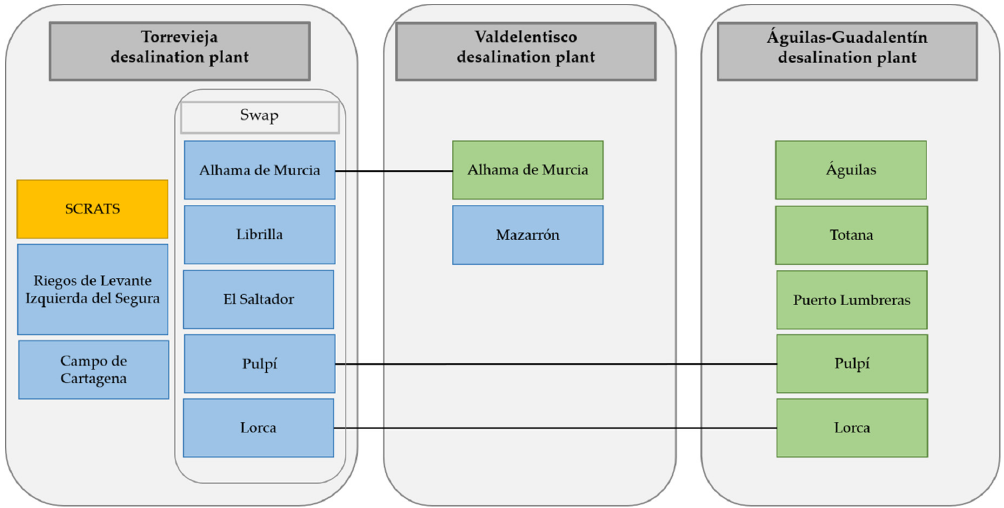
Figure 4. Irrigation communities’ connections to each desalination plant. Source: own elaboration from the questionnaires. Legend: In green, the distribution network connection to desalination plant recognized by both irrigation communities and ACUAMED; in blue, the connection only recognized by the irrigation communities; in orange, connection only recognized by ACUAMED.